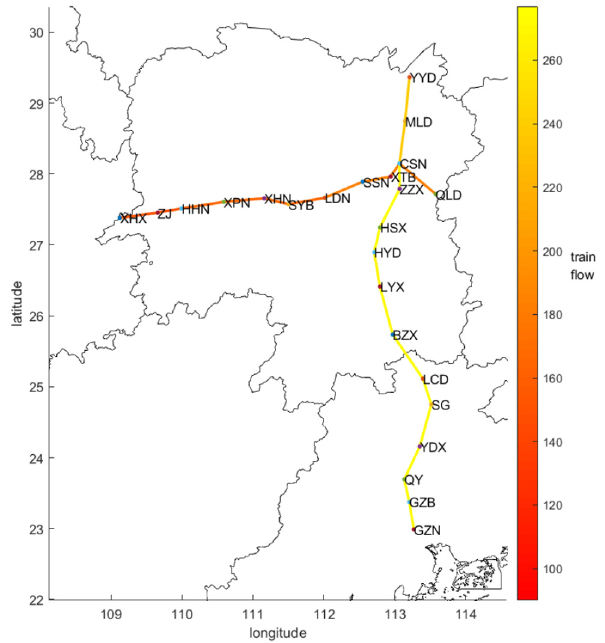
Figure 1. Railway network and section train fl